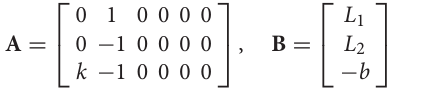
Frontiers in Neurorobotics |